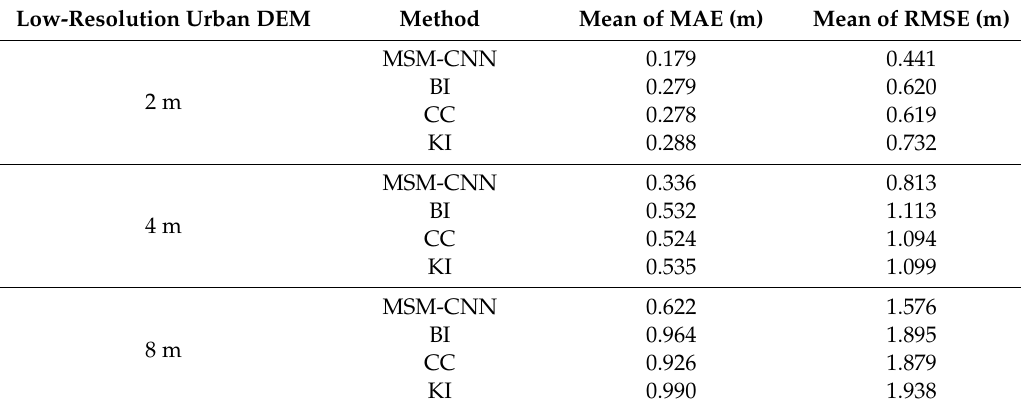
Figure 7. The accuracy statistics for di ff erent slope ranges in the whole reconstructing area: ( a – c ) root mean square errors (RMSEs) and mean absolute errors (MAEs) calculated for di ff erent DEMs reconstructed from the low-resolution 2, 4, and 8 m DEMs. The values inside the bracket below the x -axis in ( c ) are the accumulative frequency of each of the slope ranges. Table 2. Average MAEs and RMSEs calculated for di ff erent slope